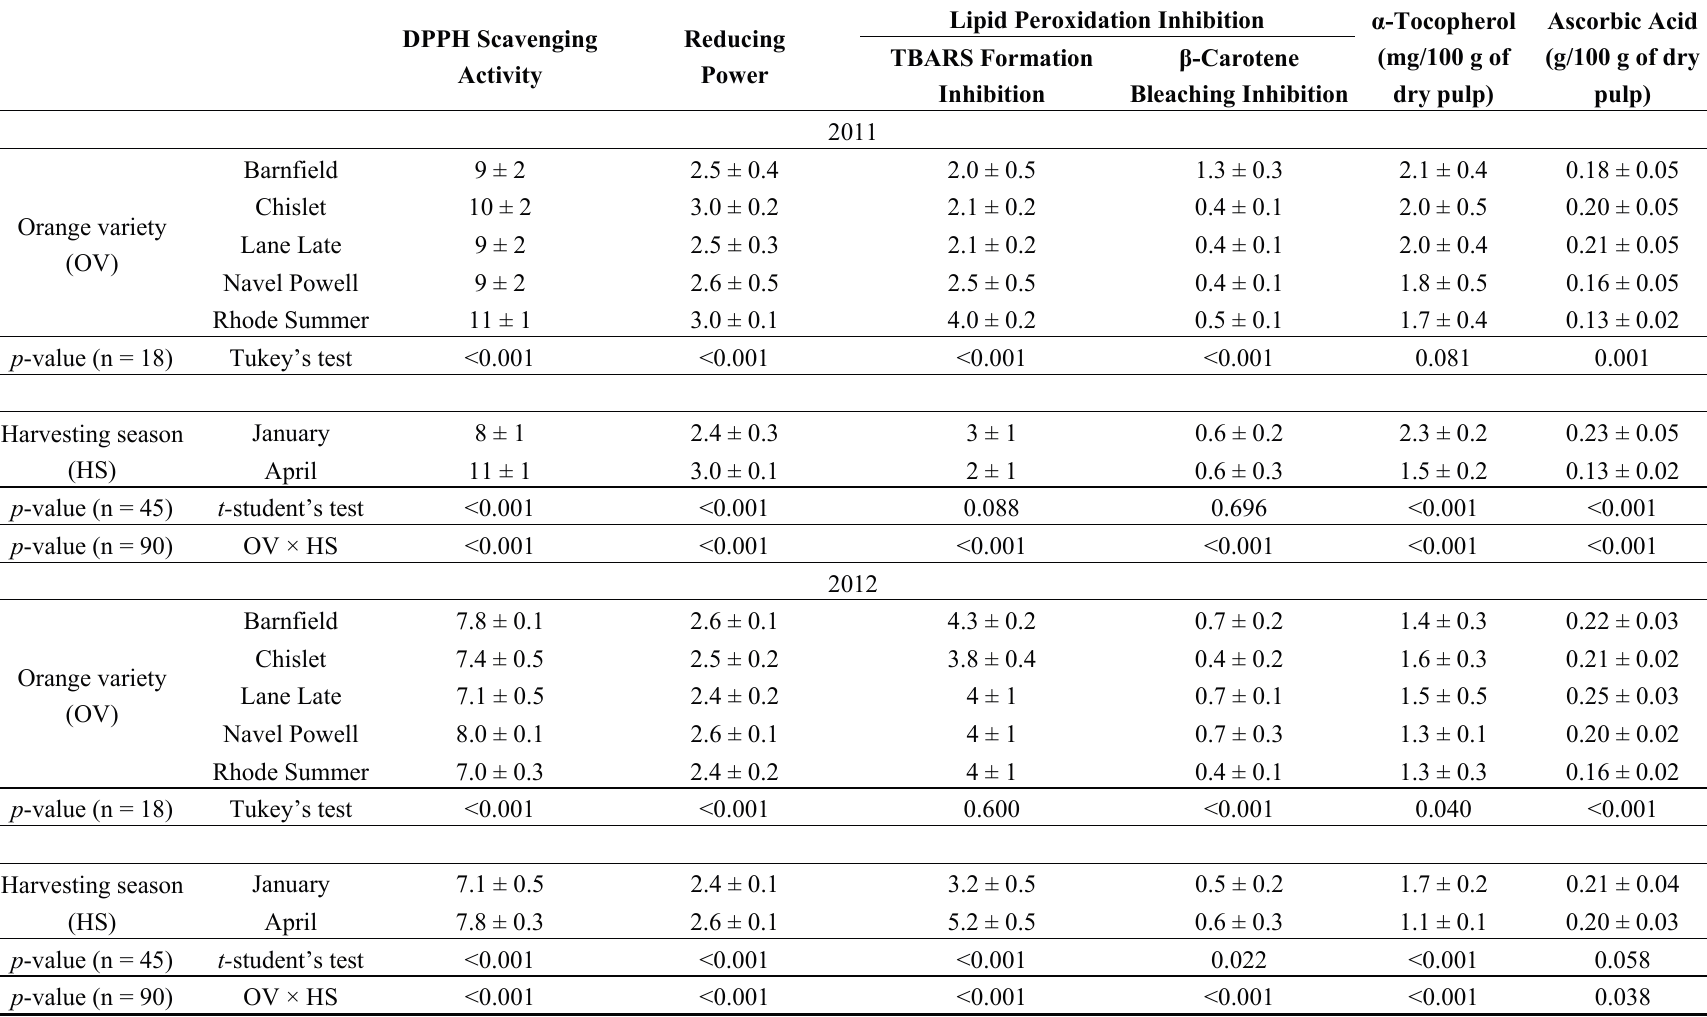
Table 1. Antioxidant properties (EC 50 values in mg/mL) and major antioxidant compounds divided by sweet orange variety (OV) and harvesting season (HS). The results are presented as mean ±